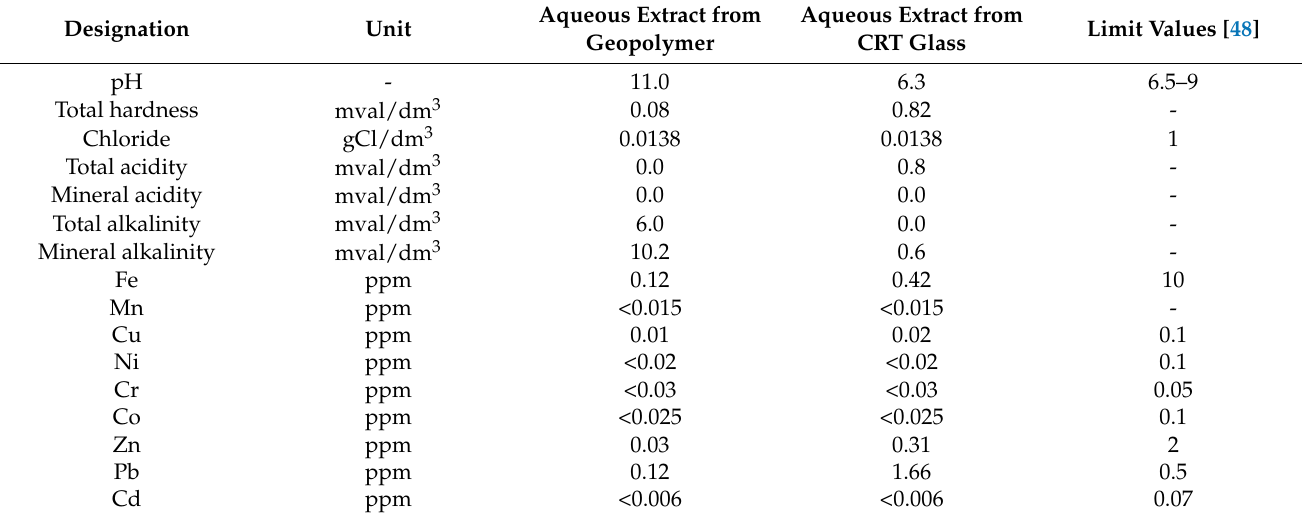
Table 6. Physicochemical analysis of aqueous extracts and the highest limit